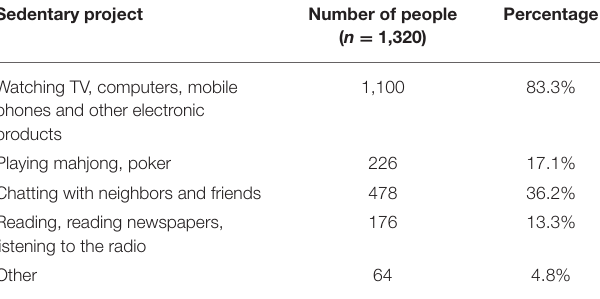
TABLE 2 | Daily SBs of rural